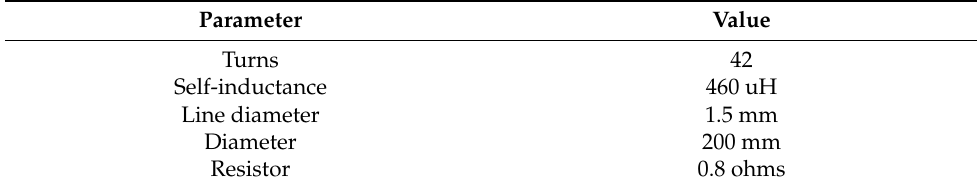
Table 5. Parameters of transmitting coil.